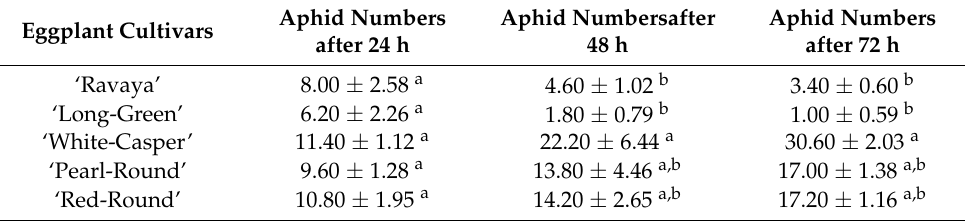
Table 2. Mean number ( ± SE) of Myzus persicae on five eggplant cultivars for antixenosis test after 24, 48, and 72 h.